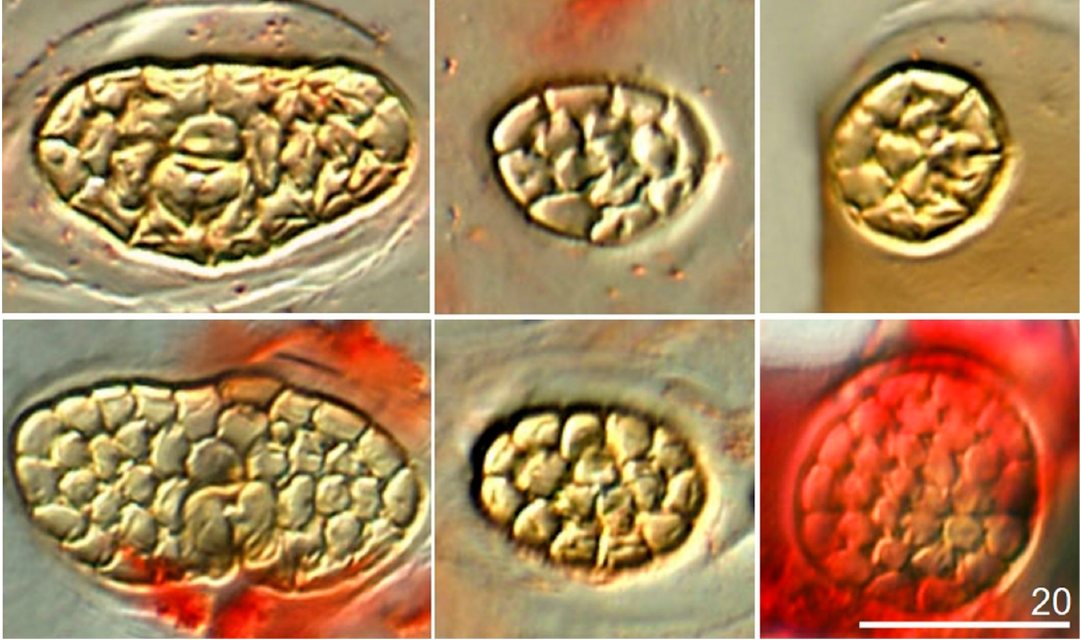
Figure A2. H. leucanthemi —second larval instar; abdominal segments VIII-XI: dorsal (left) and ventral (right) sites, Sp—spiracle, D1, D2, V1-V3—dorsal and ventral setae on abdomen included in morphometric measurements (Table 2).